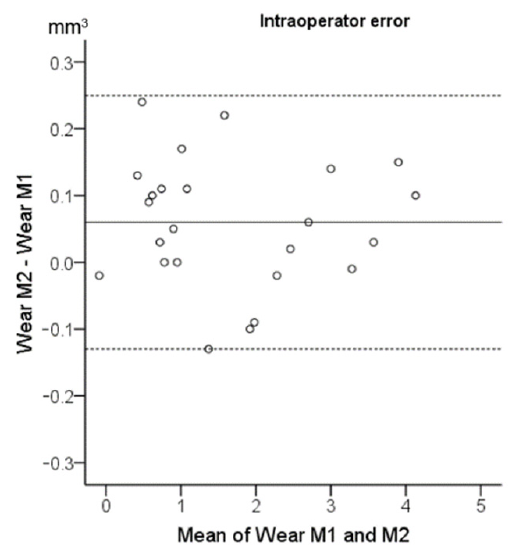
Figure 2. Bland–Altman plot showing the intraoperator reproducibility of the tooth wear assessment in mm 3 . The axes lengths represent the true range of the measured tooth wear values. The continuous horizontal line shows the mean (0.06 mm 3 ) and the dashed lines the 95% Limits of Agreement ( − 0.13, 0.25 mm 3 ). M1: first set of measurements. M2: repeated measurements.